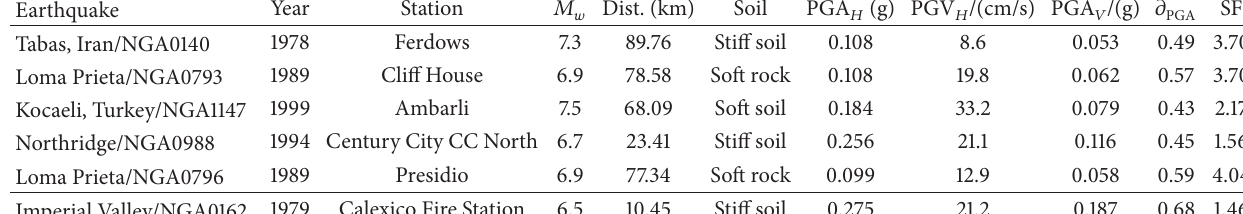
Table 5: Properties of far-fault ground motions used in the analyses. Earthquake